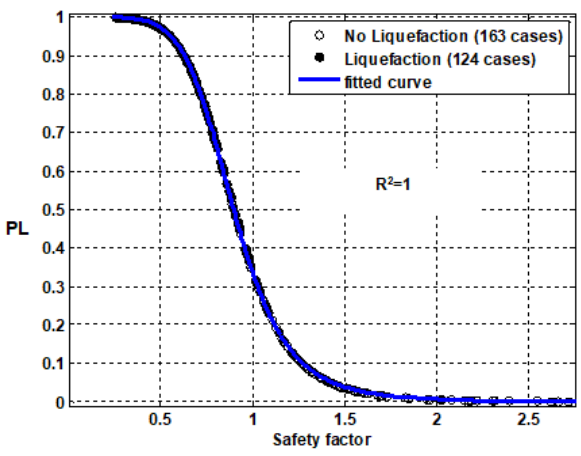
and Fs based on Bayesian Figure 5: Relationship between P L mapping function using the corrected version of the simplified procedure. PL = probability of liquefaction.